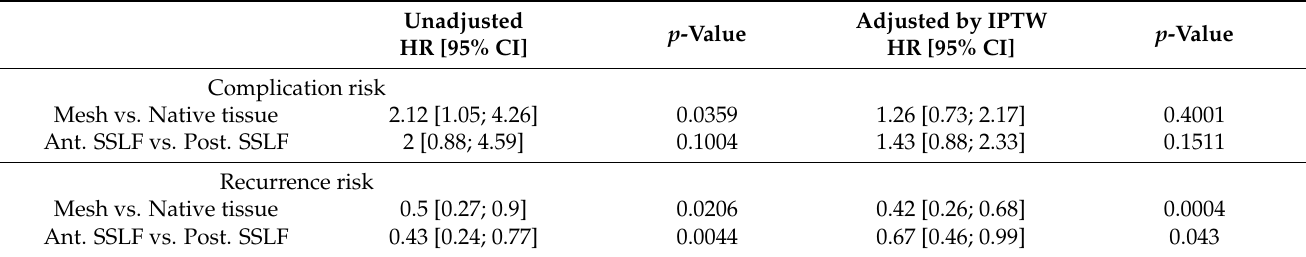
Table 5. Multivariate analysis with a propensity